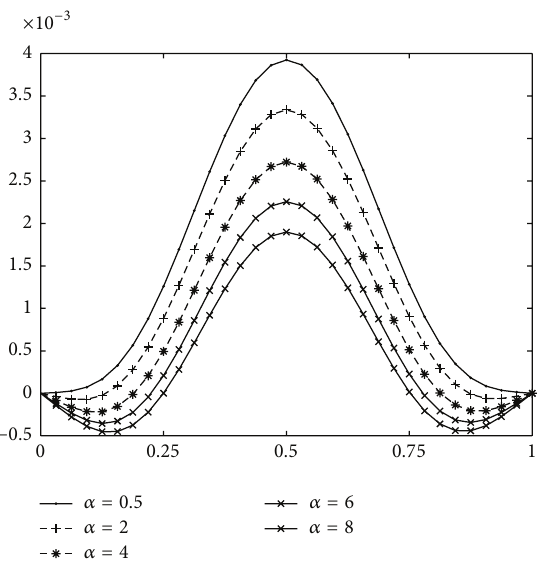
Figure 10: Numerical solutions at different 𝛼 with ℎ = 1/32 , 𝜏 = 0.1 , 𝛽 = 1 , and 𝑝 = 8 .